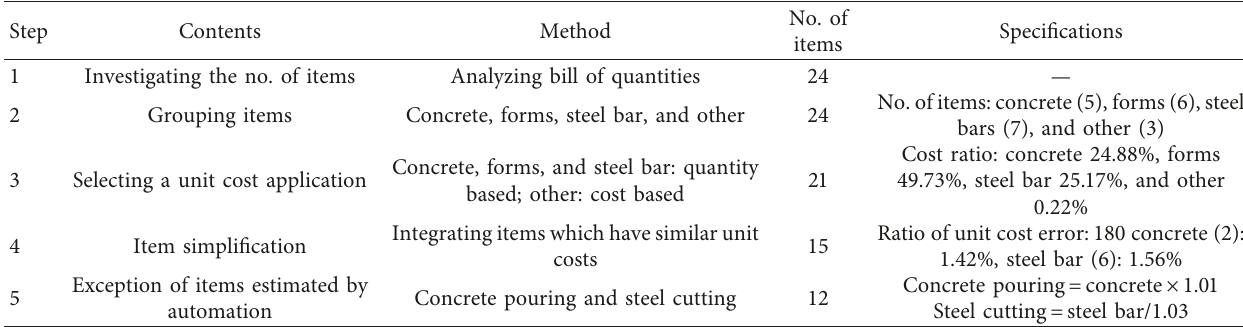
Figure 2: Relationship between CBR process and model Table 1: Item simplification.